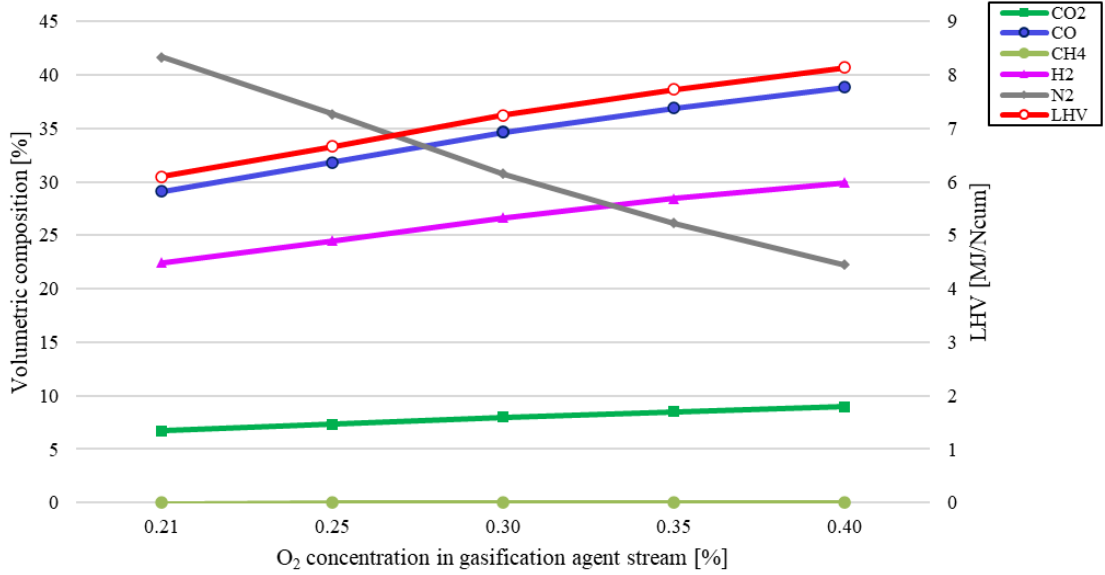
Figure 7. Composition and LHV of syngas as a function of oxygen concentration in the gasification agent.